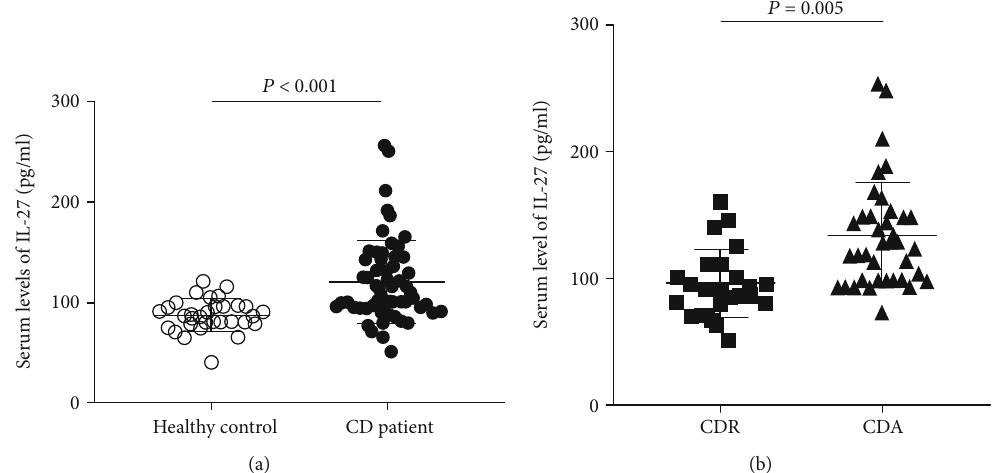
Figure 1: Comparison of serum IL-27 levels in di ff erent groups. (a) Serum IL-27 levels in control subjects and Crohn ’ s disease patients. (b) The histogram shows the serum IL-27 levels in CD patients in remission (CDR) and CD patients in activity (CDA). The di ff erences between the two groups were determined by the nonparametric Mann – Whitney rank